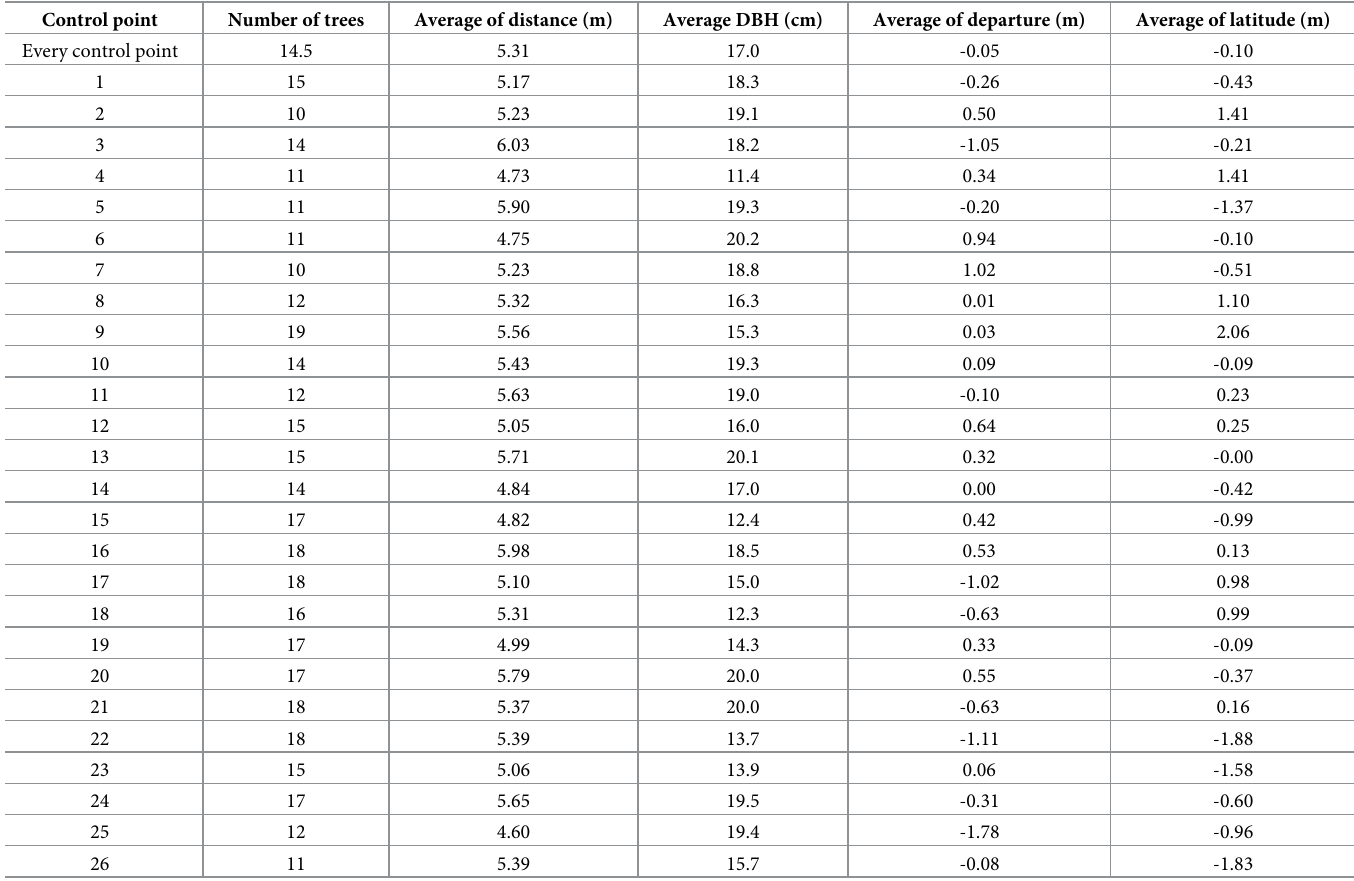
Table 2. A summary of tree characteristics within 8 m of each control